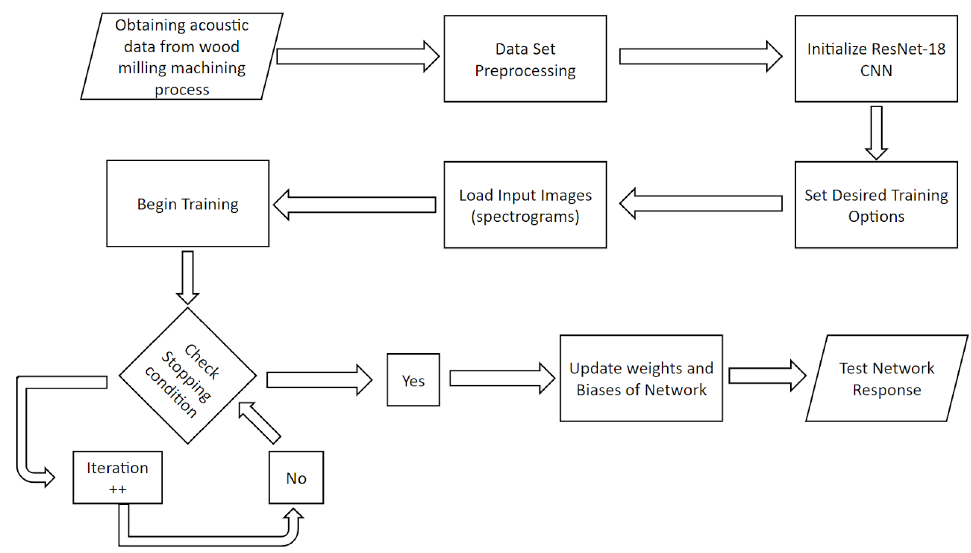
Figure 1. Flowchart of the proposed technique.